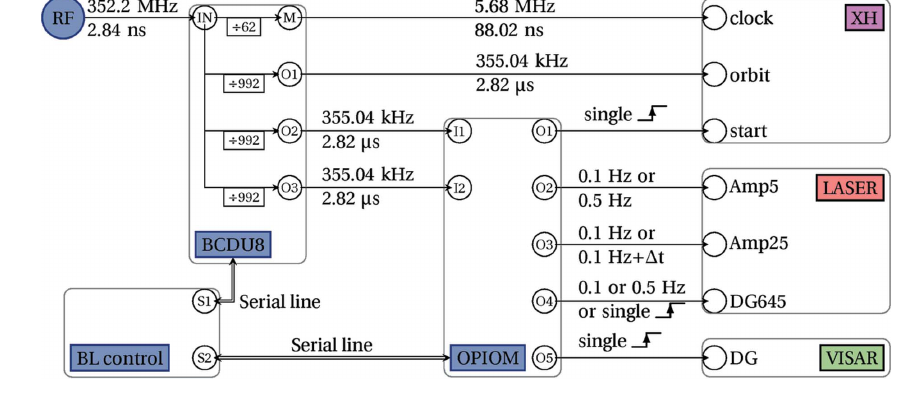
Figure 4 Schematic view of the synchronization system. The synchrotron RF is distributed to all instruments through a set of two cascaded in-house electronics (BCDU8 and OPIOM). The frequency and corresponding period are shown for each clock, while only the repetition rate is shown for trigger events.